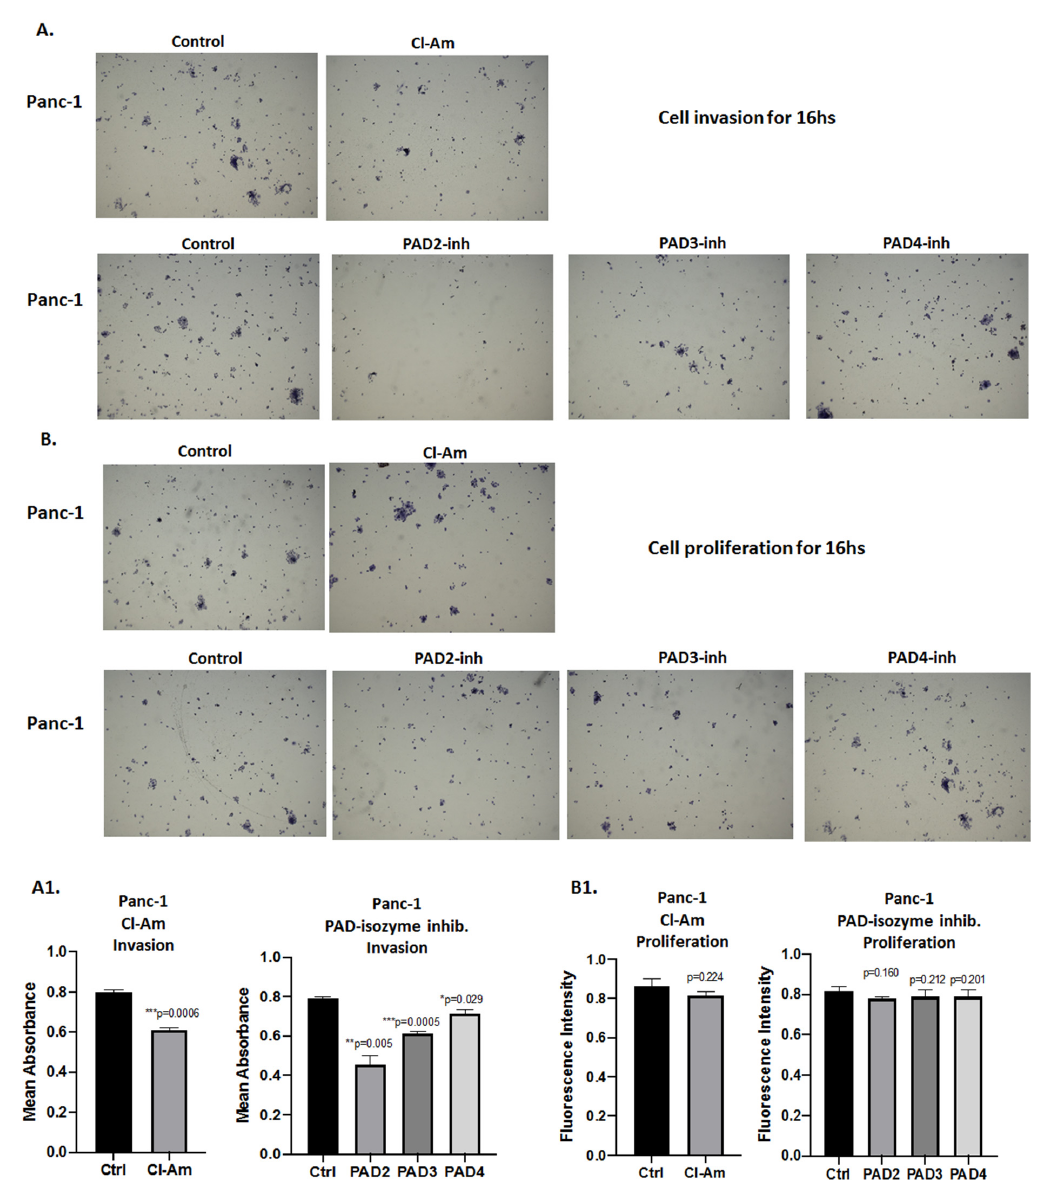
Figure 11. Cell invasion is differently affected by Cl-amidine and PAD2, 3, 4 isozyme-specific inhibitors in Panc-1 cells. ( A ) Cell invasion: Representative images (taken at 10× magnification) for cell invasion of Panc-1 cells following 16 h treat- ment with Cl-amidine and the three PAD isozyme-specific inhibitors, compared to control (PBS or DMSO) treated cells are shown; cells are stained with crystal violet. ( A1 ). The corresponding histogram for the MTT assay for Panc-1 cells, following the 16 h experiment in the presence of Cl-amidine and the three PAD isozyme-specific inhibitors, compared with control, respectively. ( B ) Cell proliferation: Representative images (taken at 10× magnification) for cell proliferation of Panc-1 cells following 16 h treatment with Cl-amidine and the three PAD isozyme-specific inhibitors, compared to control (PBS or DMSO) treated cells; cells are stained with crystal violet. ( B1 ). The corresponding histogram for Panc-1 cell proliferation following 16 h treatment with Cl-amidine and the three PAD isozyme-specific inhibitors. Exact p -values are indicated (statistically significant differences are highlighted as * p < 0.05; ** p < 0.01 and *** p < 0.001).) and error bars show SD ( n = 3 biological and 3 technical replicates for all). Figure 12. Cellular proliferation following Cl-amidine and/or PAD2, 3, 4 isozyme-specific inhibitor treatment in Panc-1 and MiaPaCa-2 cells. MTT assay showing cell proliferation after 1 h treatment with Cl-Am (50 and 100 μ m) shows little effect on either Panc-1 ( A ) or MiaPaCa-2 cells ( C ), albeit in some cases statistical significance is reached. Similarly, PAD2